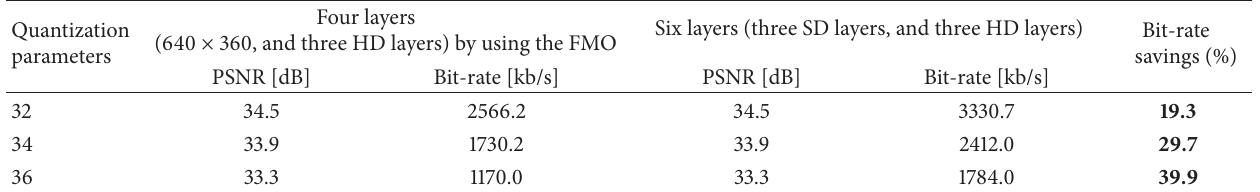
Table 6: FMO: four-layer coding versus six-layer coding (“ STOCKHOLM ”, 30fps, 96 frames, GOP size 8).